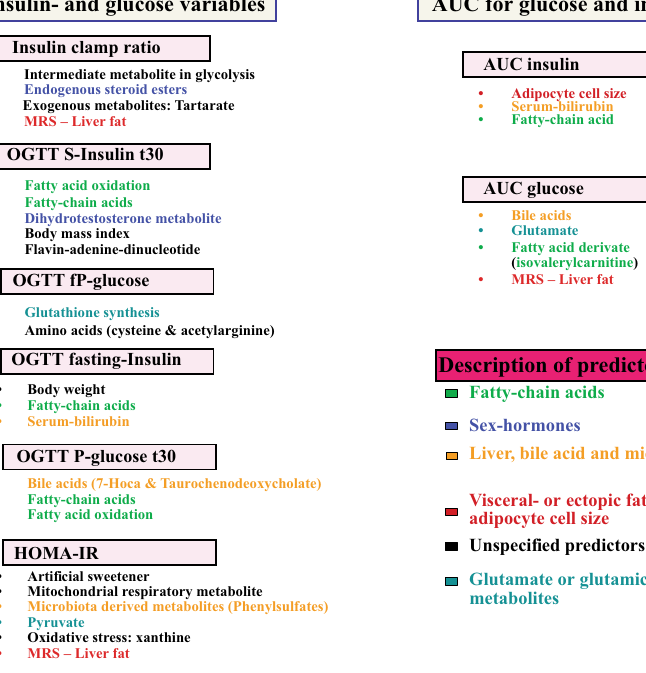
Figure 5. Overview of important predictors for glucose- and insulin metabolism, as well as, radiological examinations and adipocyte cell size. Relative importance for predictors was ranked according to highest relative contribution in machine learning models and thereafter with linear regression models. The most important and significant predictors for each model is presented in this summary